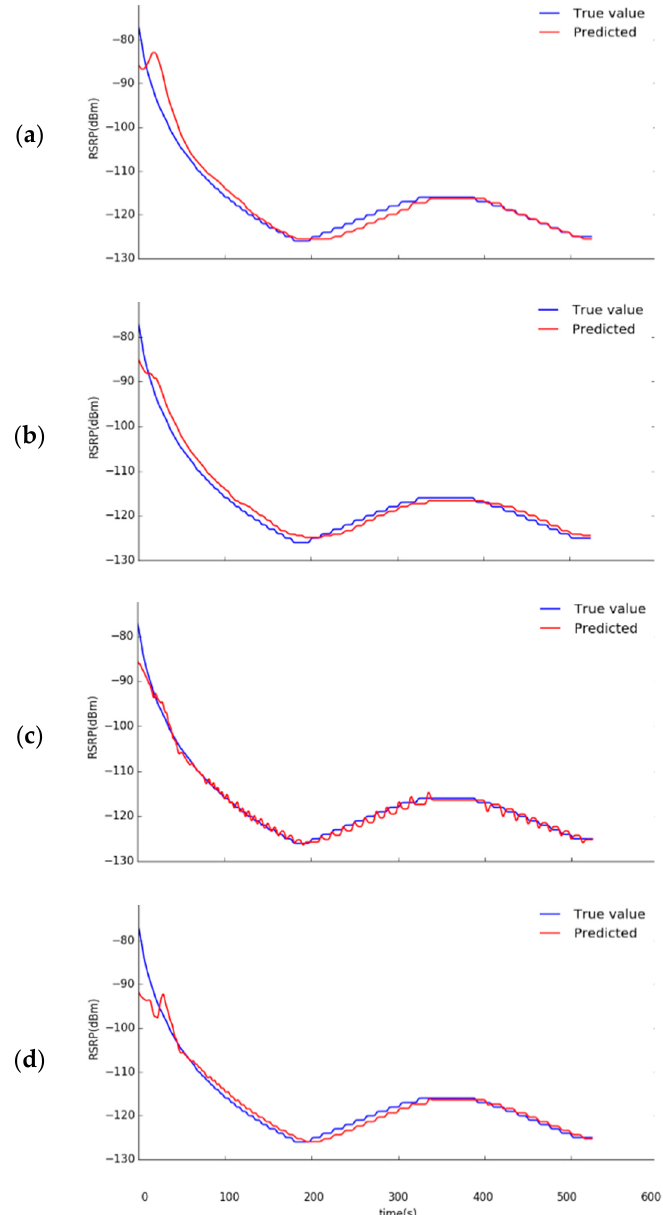
Figure 19. Predicted RSRP results for the next 10 s: ( a ) MLP, ( b ) CNN, ( c ) RNN, ( d ) LSTM.